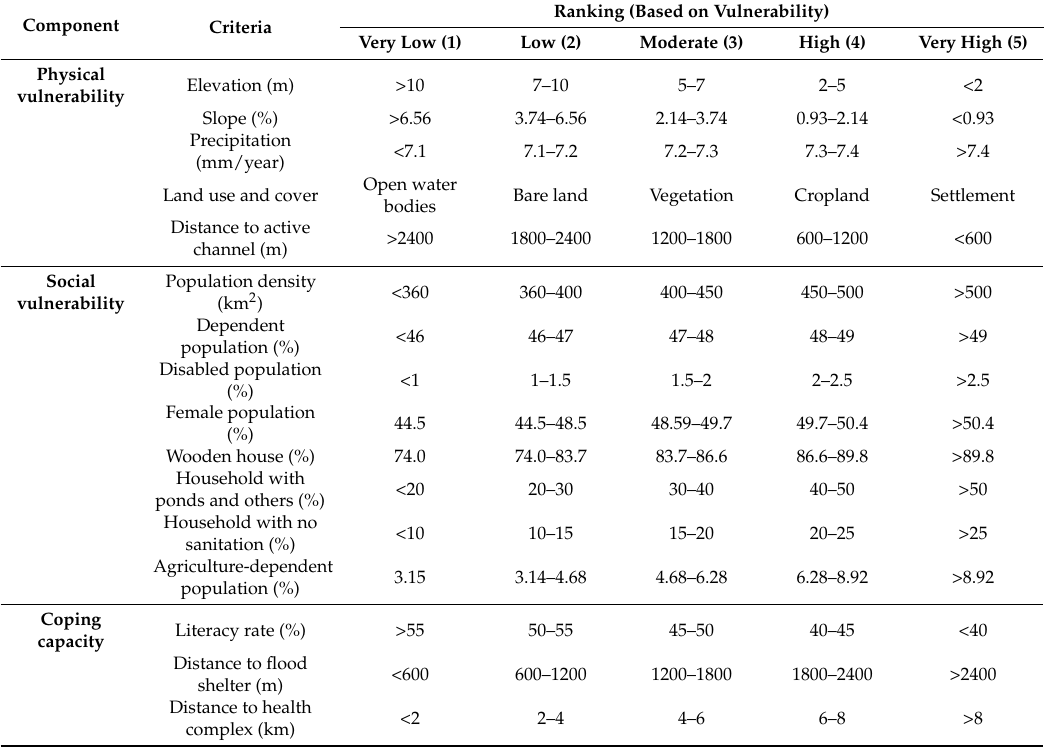
Table 2. Alternative ranking scheme based on the contribution to risk flood disaster.